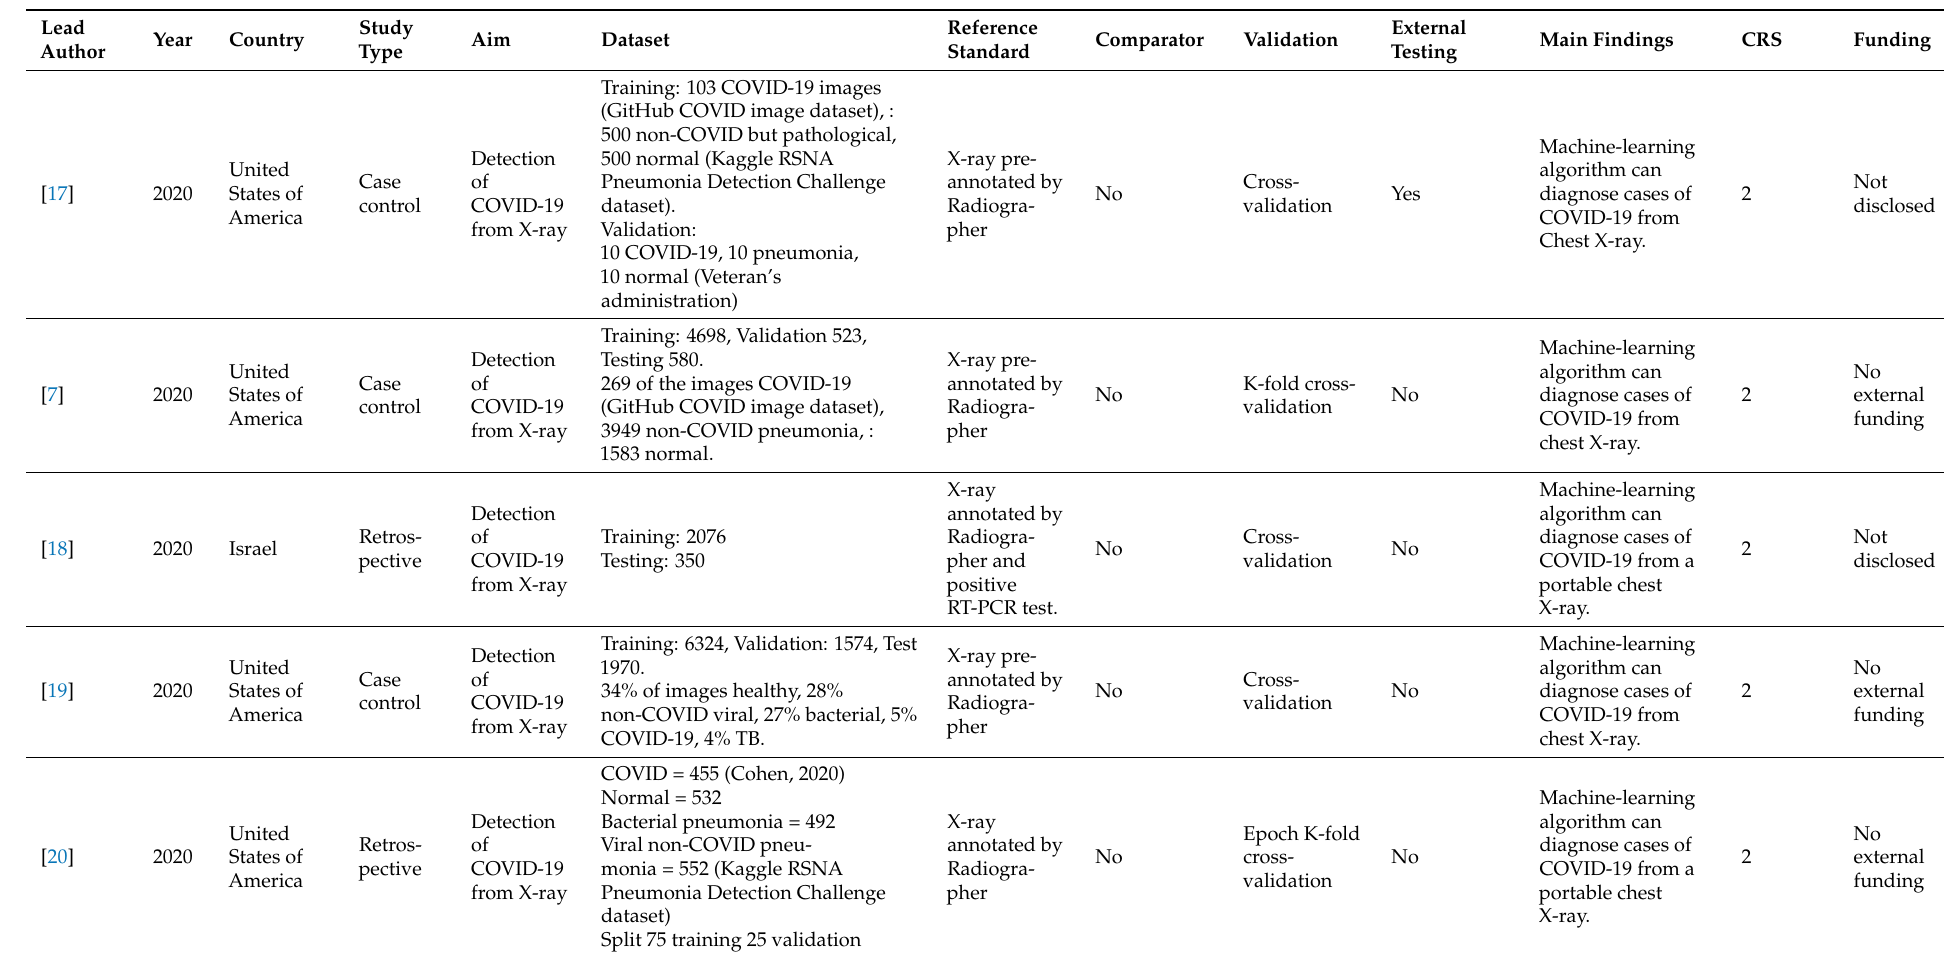
Table 1. Modified TRIPOD assessment of X-ray